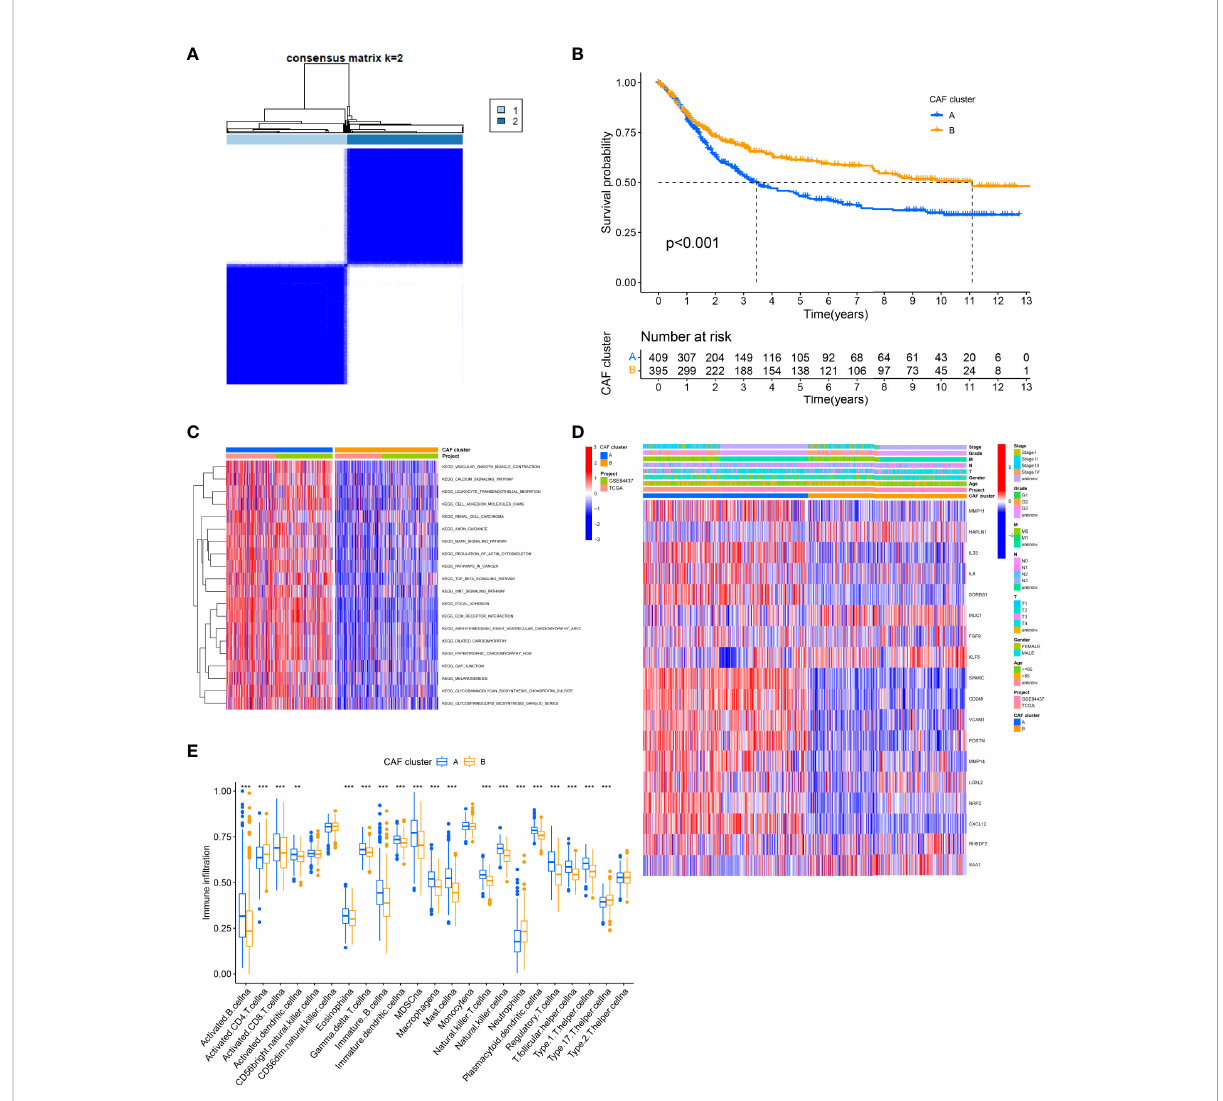
FIGURE 2 Identi fi cation of CAFs subtypes in GC. (A) Consensus matrix heatmap de fi ning two clusters (k = 2) and their correlation area. (B) Univariate analysis indicating 18 CAFs-related genes corelated with the OS time. (C) GSVA of biological pathways between two distinct subtypes. (Red and blue represent activated and inhibited pathways, respectively). (D) Differences in clinicopathologic features and expression levels of CAFs-related genes between the two distinct subtypes. (E) The 22 in fi ltrating immune cell types in the two GC subtypes. **P<0.01,